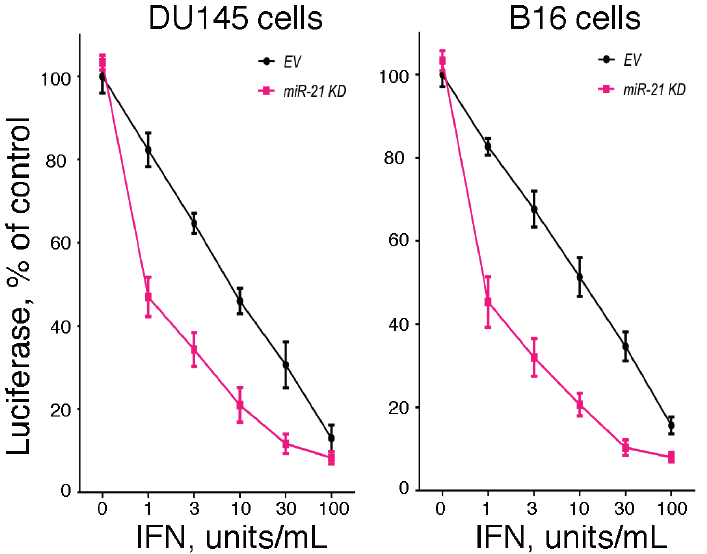
Figure 1. The role of miR-21 in the antiviral action of IFN. Empty vector (EV)- and antagomiR-21 transduced (miR-21 KD) human DU145 prostate cancer cells or murine B16 melanoma cells were added to 48-well plates (1 × 10 4 cells/well). After incubation